Question: What kind of plot is shown here?
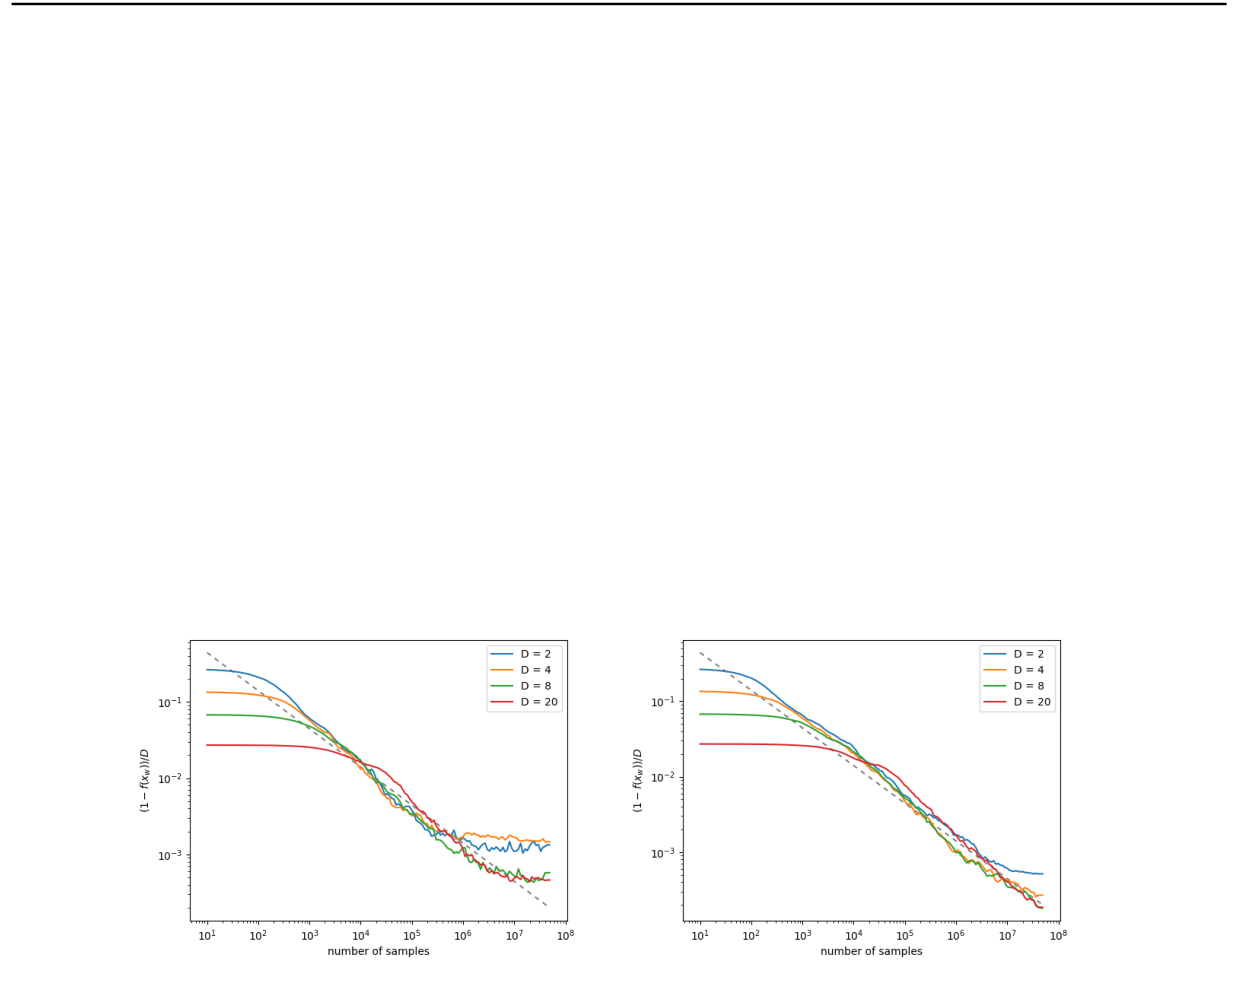
Answer: line